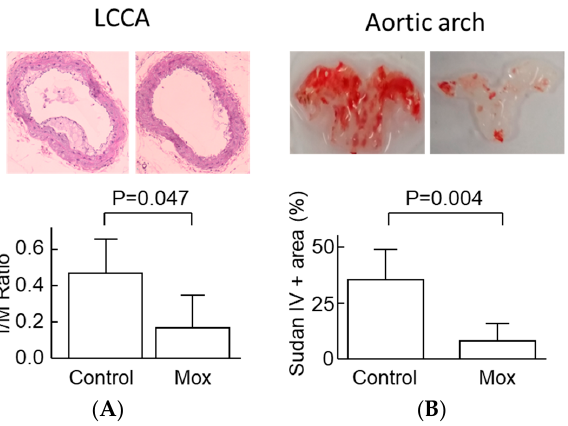
Figure 6. Effect of moxonidine on atherosclerosis in apolipoprotein E-deficient mice. ( A ) The left common carotid artery was stained with the H&E method. The ratio of the lesion area over the medial area (I/M ratio) was calculated. Magnification = 10×. ( B ) The aortic arch was stained with Sudan IV to visualise the lipid in the lumen surface of the aortic arch. The difference between the two groups was analysed by the Mann–Whitney U test. Error bars represent SD; N = 6 per group. H&E, hematoxylin and eosin; LCCA, left common carotid artery; Mox, moxonidine.